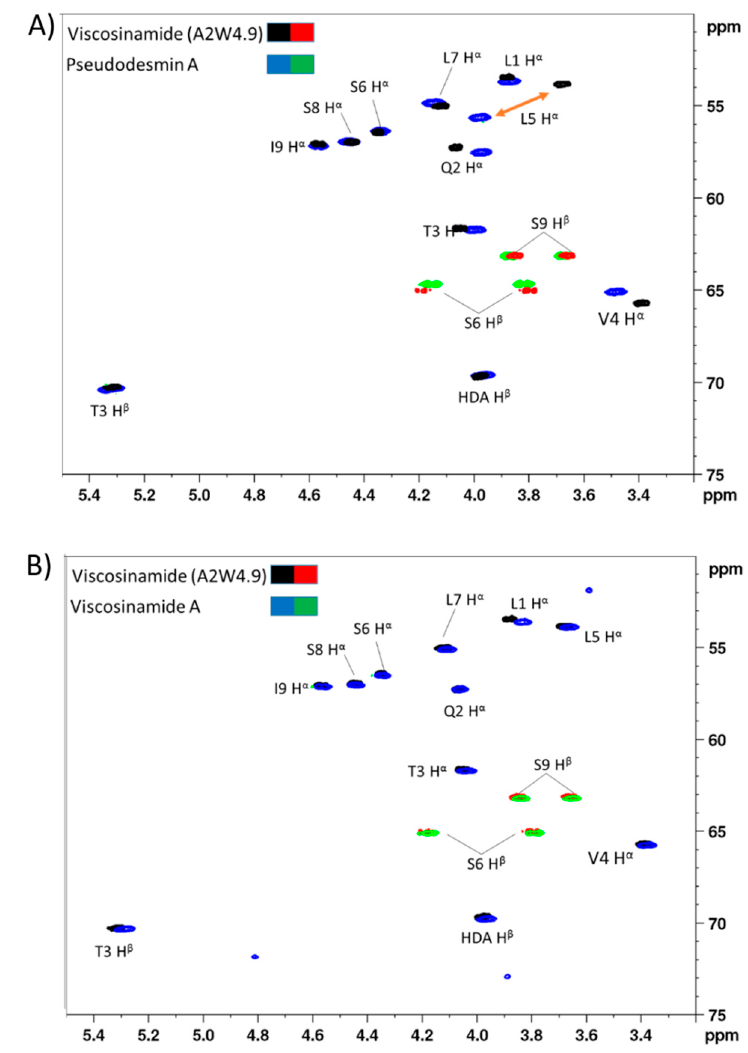
Figure A2. ( A ) Overlay of the alpha region of a 1 H- 13 C gHSQC spectrum of the isolated CLP (black/red) with that of pseudodesmin A (blue/green) recorded under identical conditions. A significant difference occurs for the 1 H and 13 C chemical shifts of Leu5. It is likely that the isolated CLP has a different stereochemistry at this position. ( B ) Overlay of the alpha region of a 1 H- 13 C gHSQC spectrum of the isolated CLP (black/red) with that of viscosinamide A (blue/green) recorded under identical conditions. Both spectra are undistinguishable, showing that the isolated CLP of Pseudomonas sp. A2W4.9 is identical to viscosinamide A.